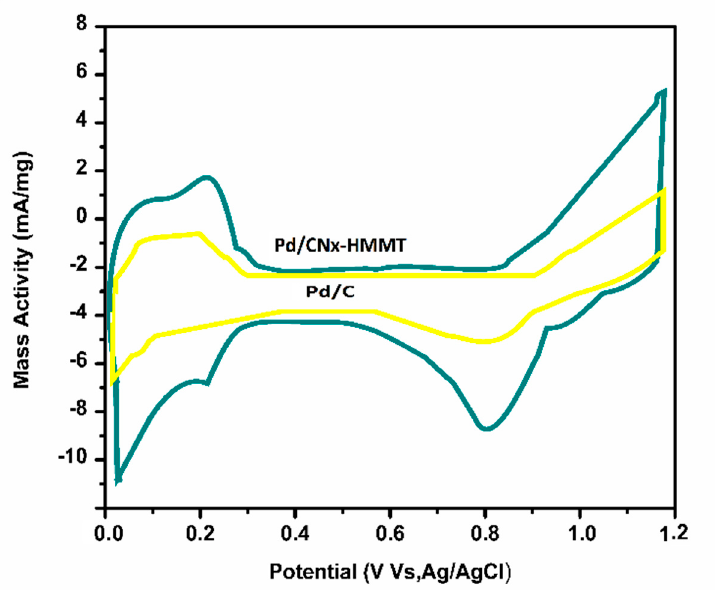
Figure 6. Cyclic voltammograms (CVs) of Pd/C and Pd/CNx-HMMT.